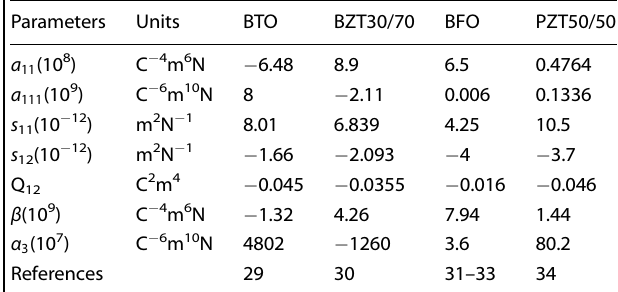
Table 1. Parameters used for BTO, BZT 30/70, BFO, PZT 50/50 fi lms in Fig. 1.